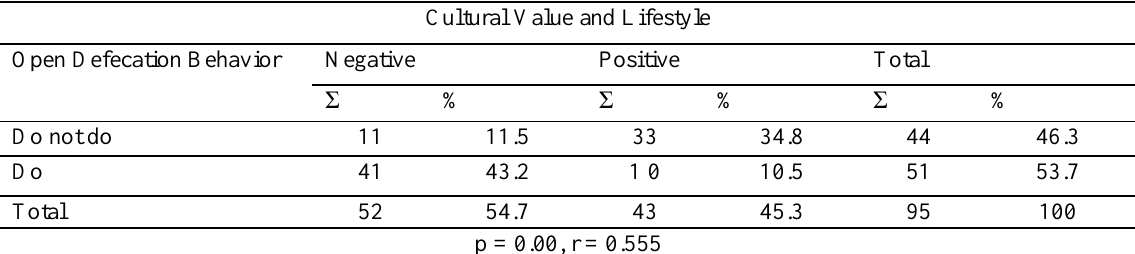
Table 3. The relationship between cultural value and lifestyle and open defecation behavior in school age children Cultural Value and Lifestyle Open Defecation Behavior